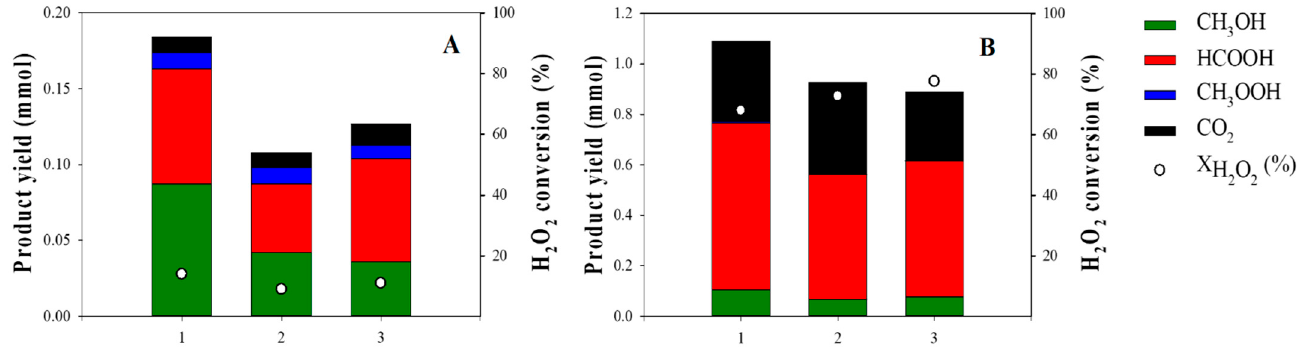
Figure 5. The recycle test with 0.56%Cu-0.30%Fe/ZSM-5(IE) at 30 °C ( A ) and 50 °C ( B ). Reaction conditions: 50 mg catalyst, 31 bar methane, 0.277 M H 2 O 2 , liquid volume = 30 mL.